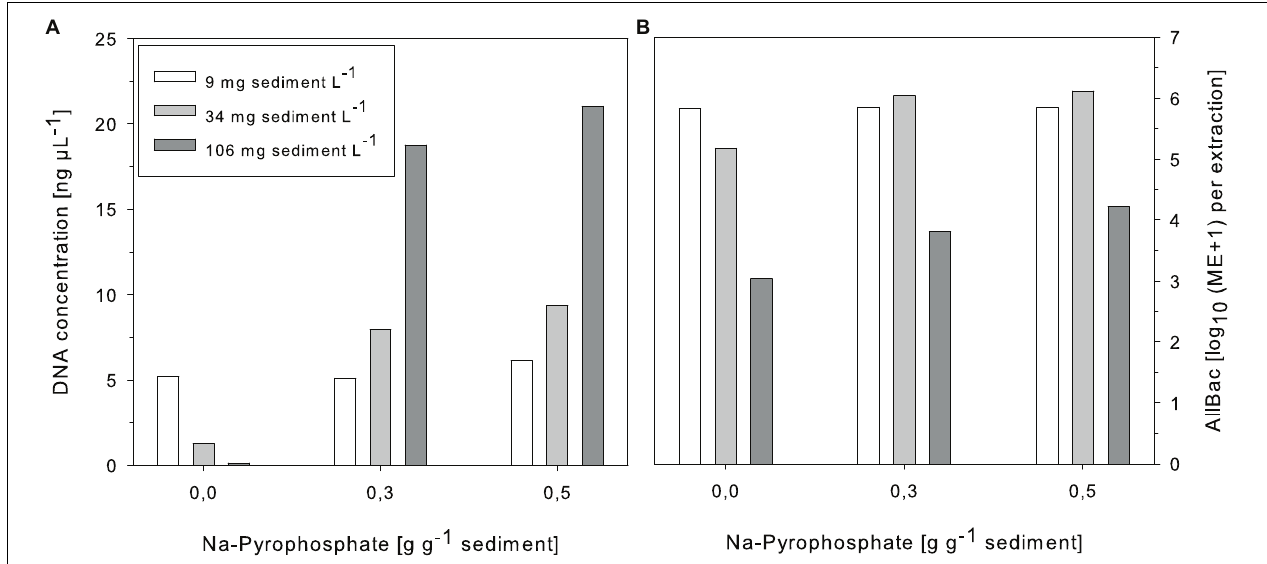
FIGURE 3 | Effects of Na-pyrophosphate supplementation during DNA extraction on the DNA yield (A) and AllBac marker concentrations (B) of sediment-enriched samples. ME, Marker equivalents, n = 1.